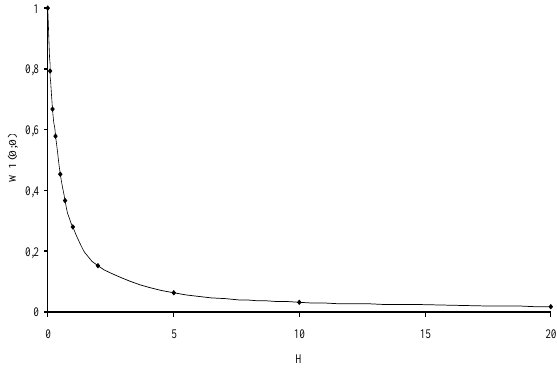
Fig. 2. Graph of the probability of departure from the systems without colliding with the walls.